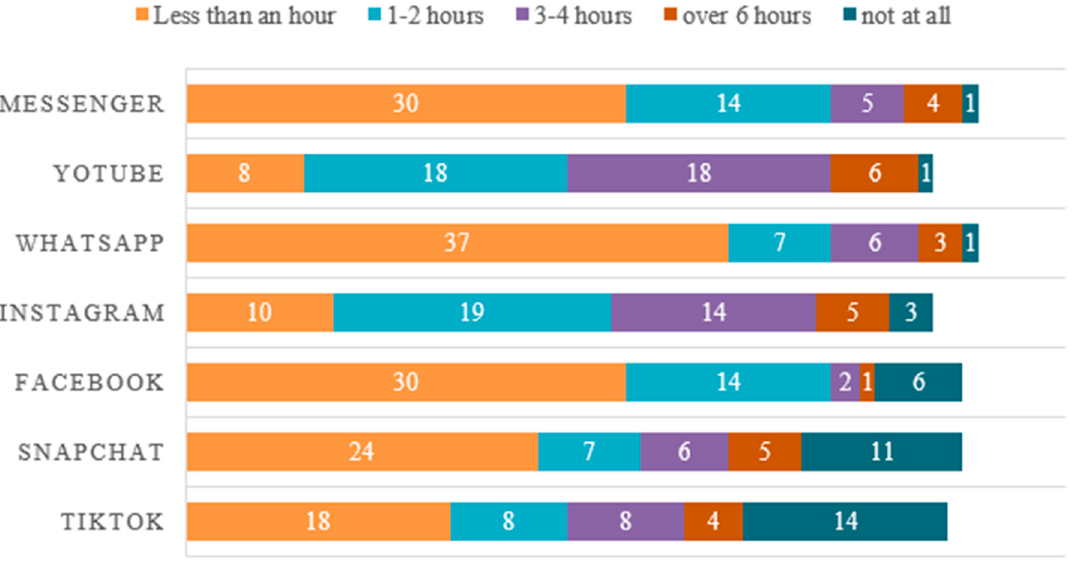
Figure 3. Time spent on each social network.